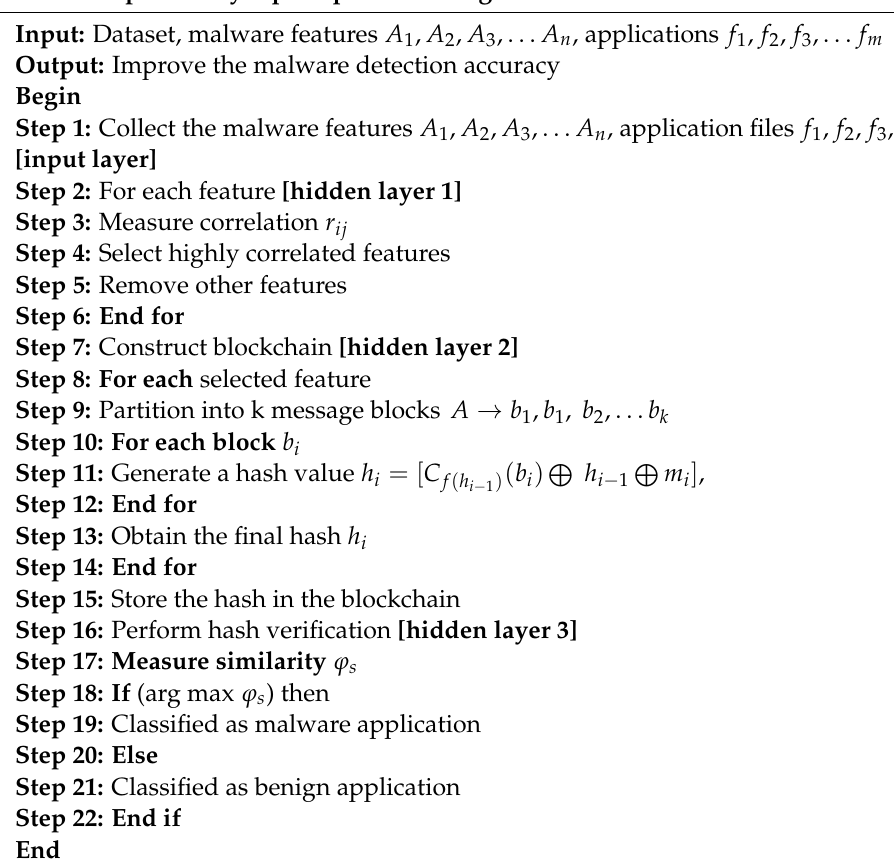
Algorithm 1: Biserial correlative Miyaguchi–Preneel blockchain-based Ruzicka index deep multilayer perceptive